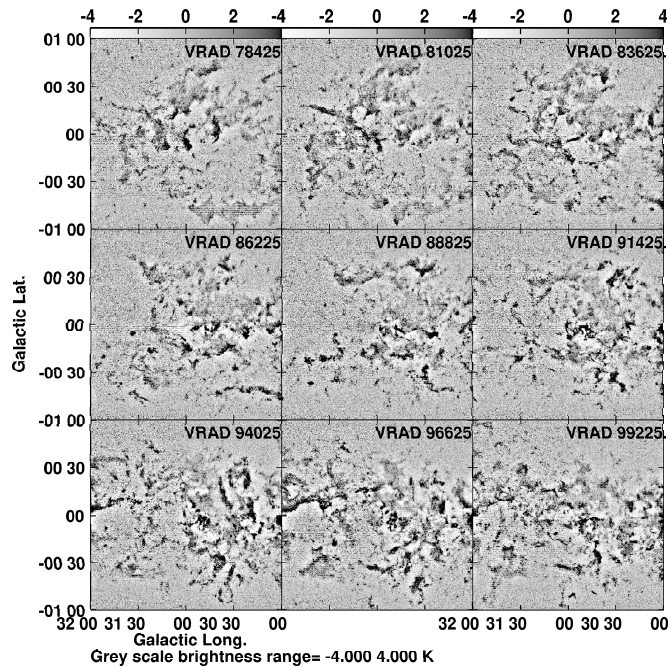
Figure A2. Same as Figure A1, but extended structures have been subtracted in order to enhance shells and